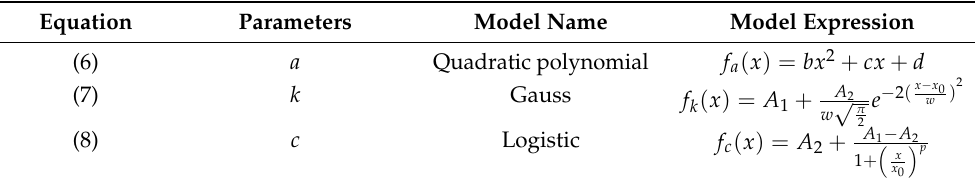
Table 3. Relational expression of each parameter and CGSS.